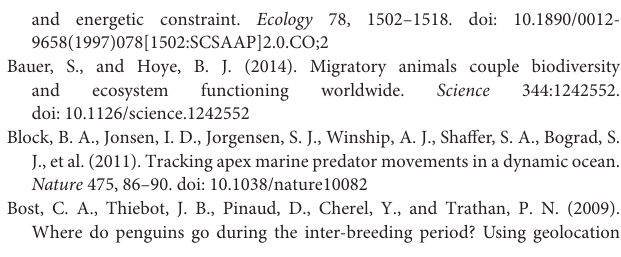
Supplementary Figure 1 | Density distributions of sooty terns ( N = 36 birds and 53 annual tracks) from Bird Island (white triangle) during the non-breeding, pre-laying and breeding periods Density contours encompass home ranges (90% kernel). For the non-breeding period, locations were concentrated in four main areas: in the Bay of Bengal (A) , on each side of the Chagos-Laccadive plateau (B) , on each side of the 90 East Ridge (C), and around Comoros (D) . Units are in